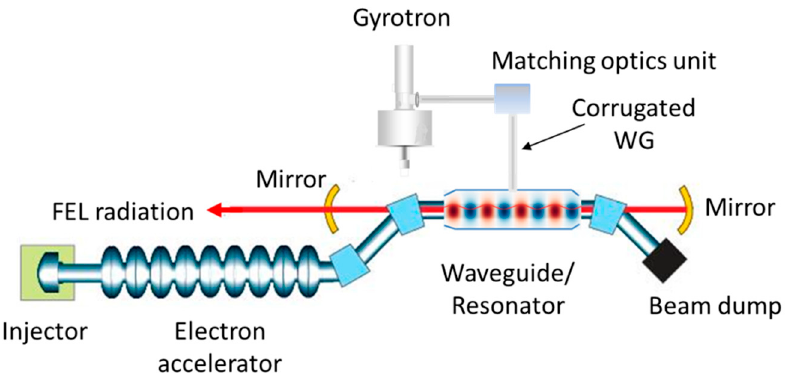
Figure 3. Schematic of an FEL with gyrotron-powered microwave wiggler/undulator (different components not to scale).